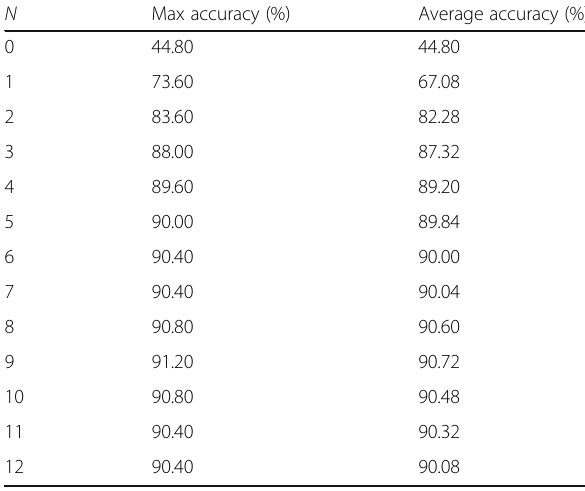
Table 4 Maximum obtained accuracy (max accuracy) and average value of the top 10 obtained values for accuracy (average accuracy) for the five-class problem, for N = 0 – 12 N Max accuracy (%)